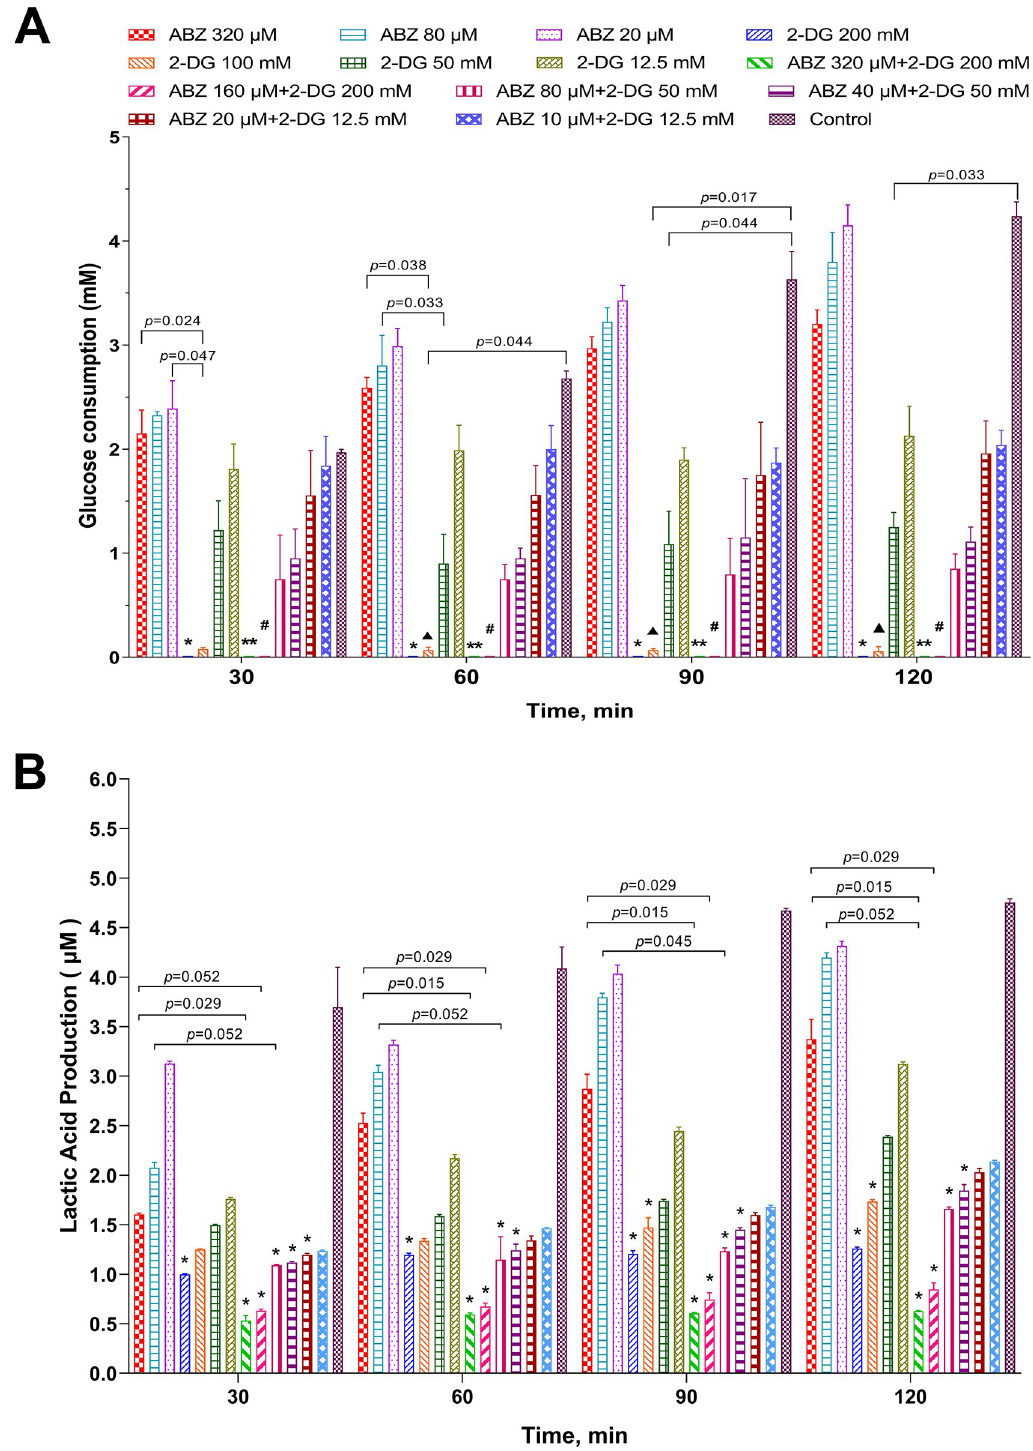
Fig 8. Effects of ABZ, 2-DG, ABZ + 2-DG, or ABZ half-dose + 2-DG on glucose metabolism of E . multilocularis metacestodes. Various concentrations of ABZ, 2-DG, or combined ABZ/2-DG were preincubated with 200 μ g metacestodes slices for 30 minutes at 37˚C, and then the slices were incubated in the presence of 6 mM glucose. (A) Glucose consumption was determined for the times indicated. � p < 0.05, 2-DG 200 mM–treated group vs. control group, ABZ 320 μ M, ABZ 80 μ M,